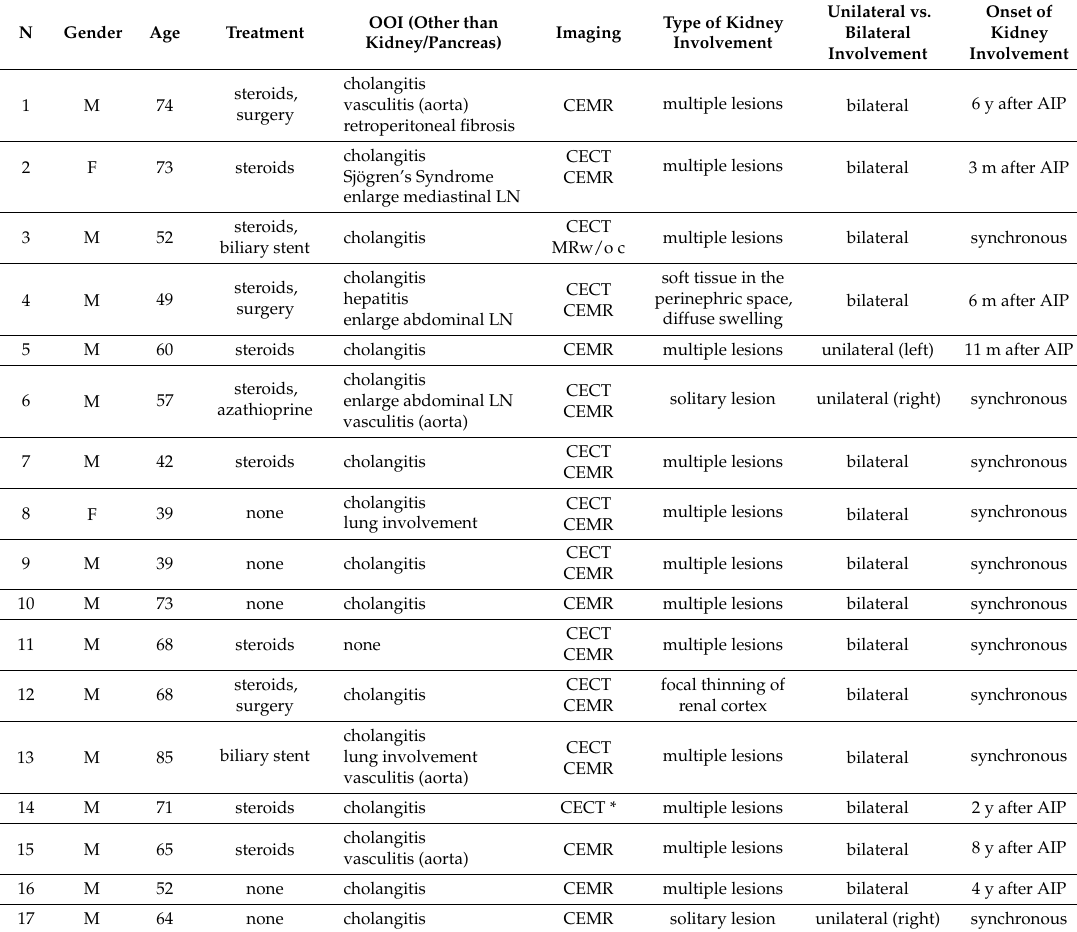
Table 1. Demographic, clinical and radiological characteristics of individual